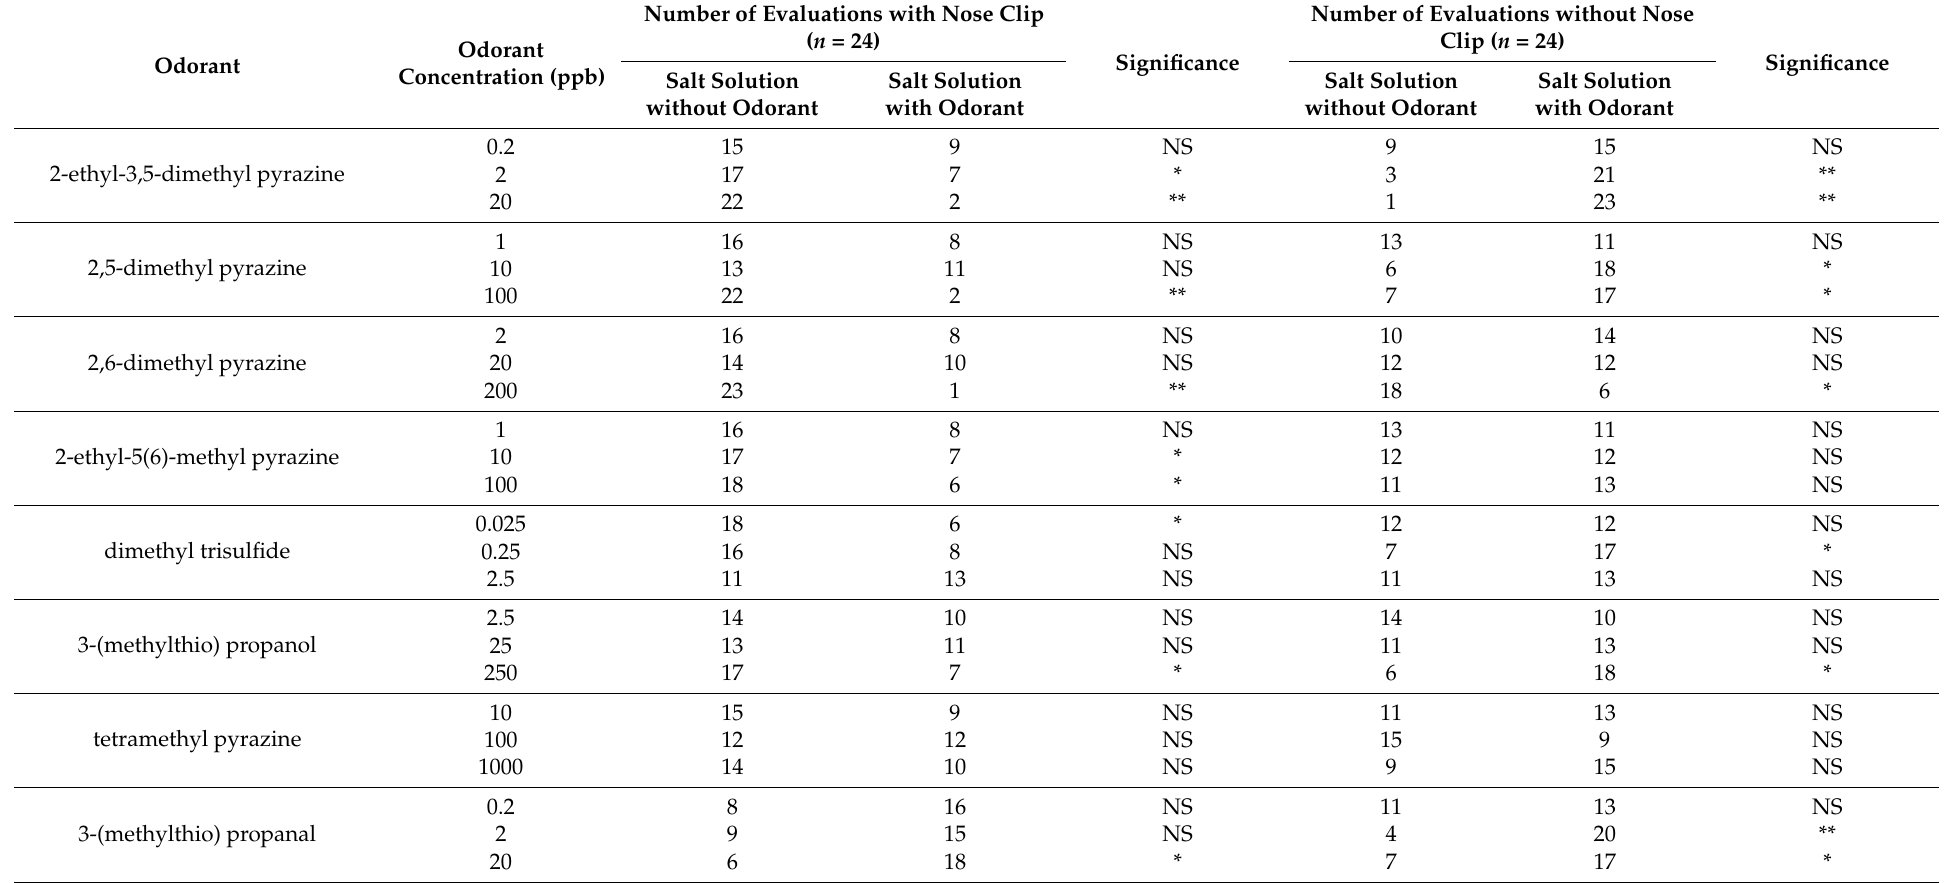
Table 2. Sensory evaluation of saltiness for salt solution with and without odorant (paired